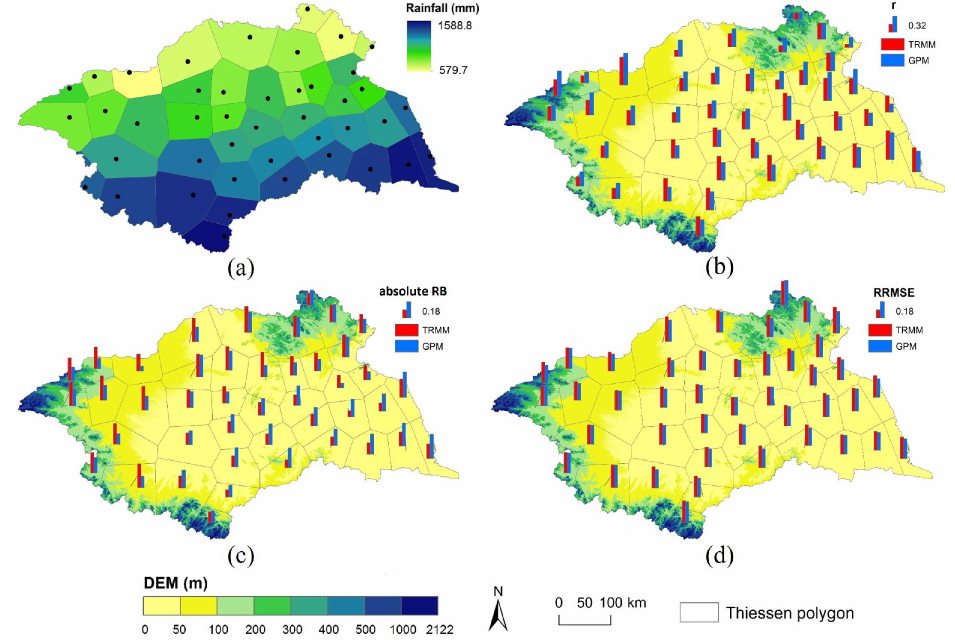
Figure 7. Evaluation results at each individual gauge station in the Huaihe River basin from 2015 to 2017. ( a ) Annual rainfall of rain gauge; ( b – d ) r , absolute RB , and RRMSE of 3B42 v7 and IMERG v5 precipitation products.